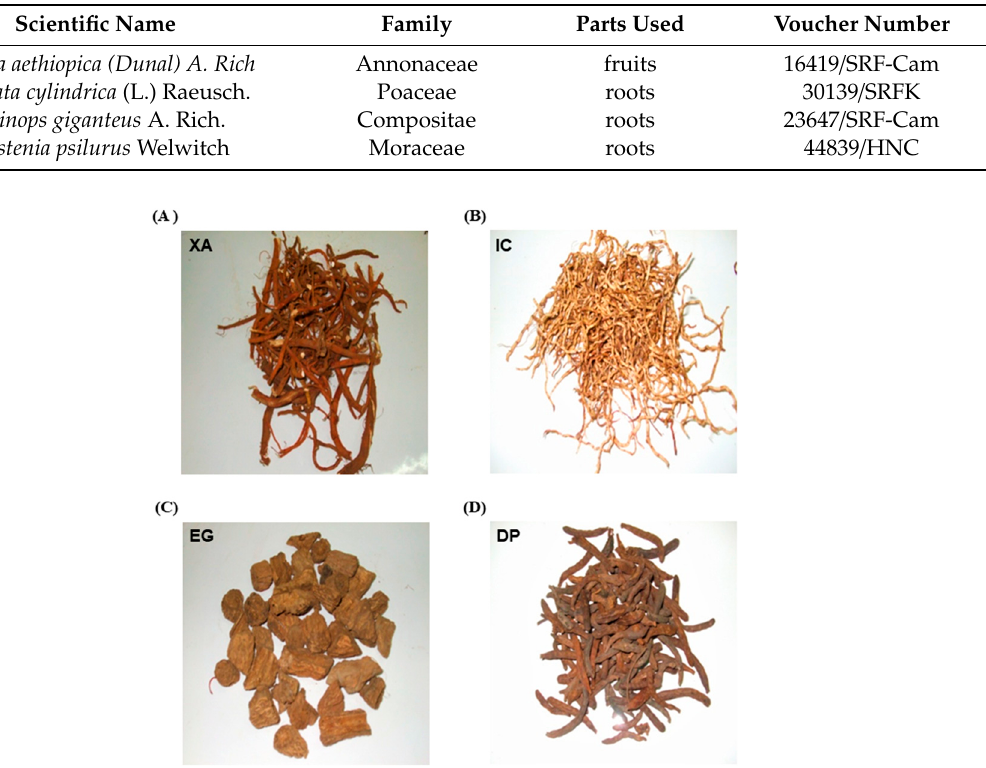
Table 2. The botanical origin of the four studied plant extracts.